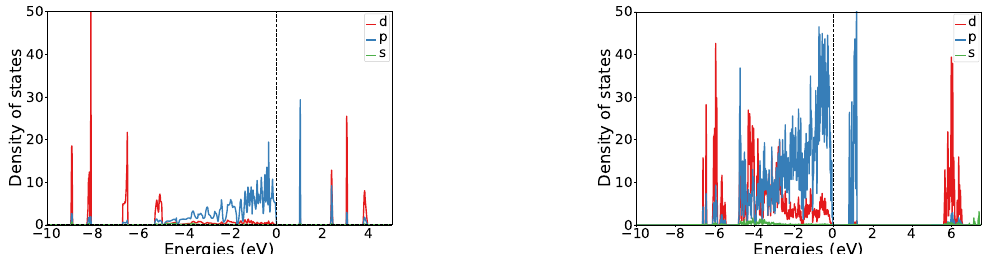
Figure 2. Orbital resolved density of states plots for structure I ( left ) and V ( right ). NB: Because of overall antiferromagnetism the plots are symmetric with respect to the x-axis and only the upper part is